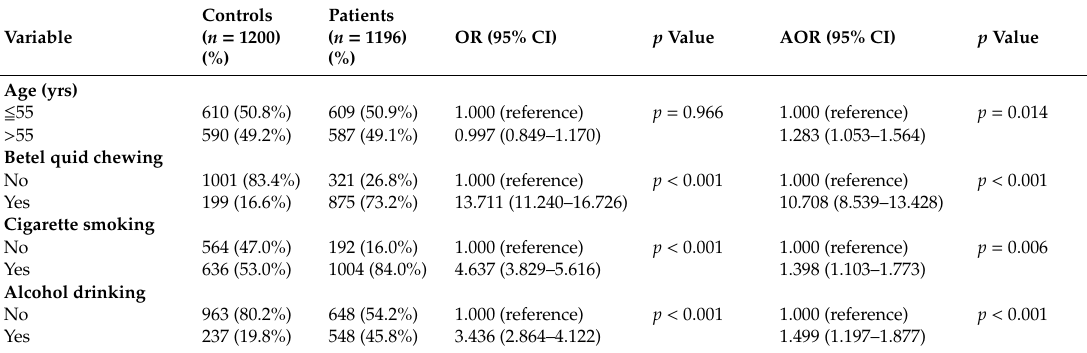
Table A1. The odds ratio (OR) and adjusted odds ratio (AOR) and 95% confidence interval (CI) of oral cancer associated with SOX11 genotypic